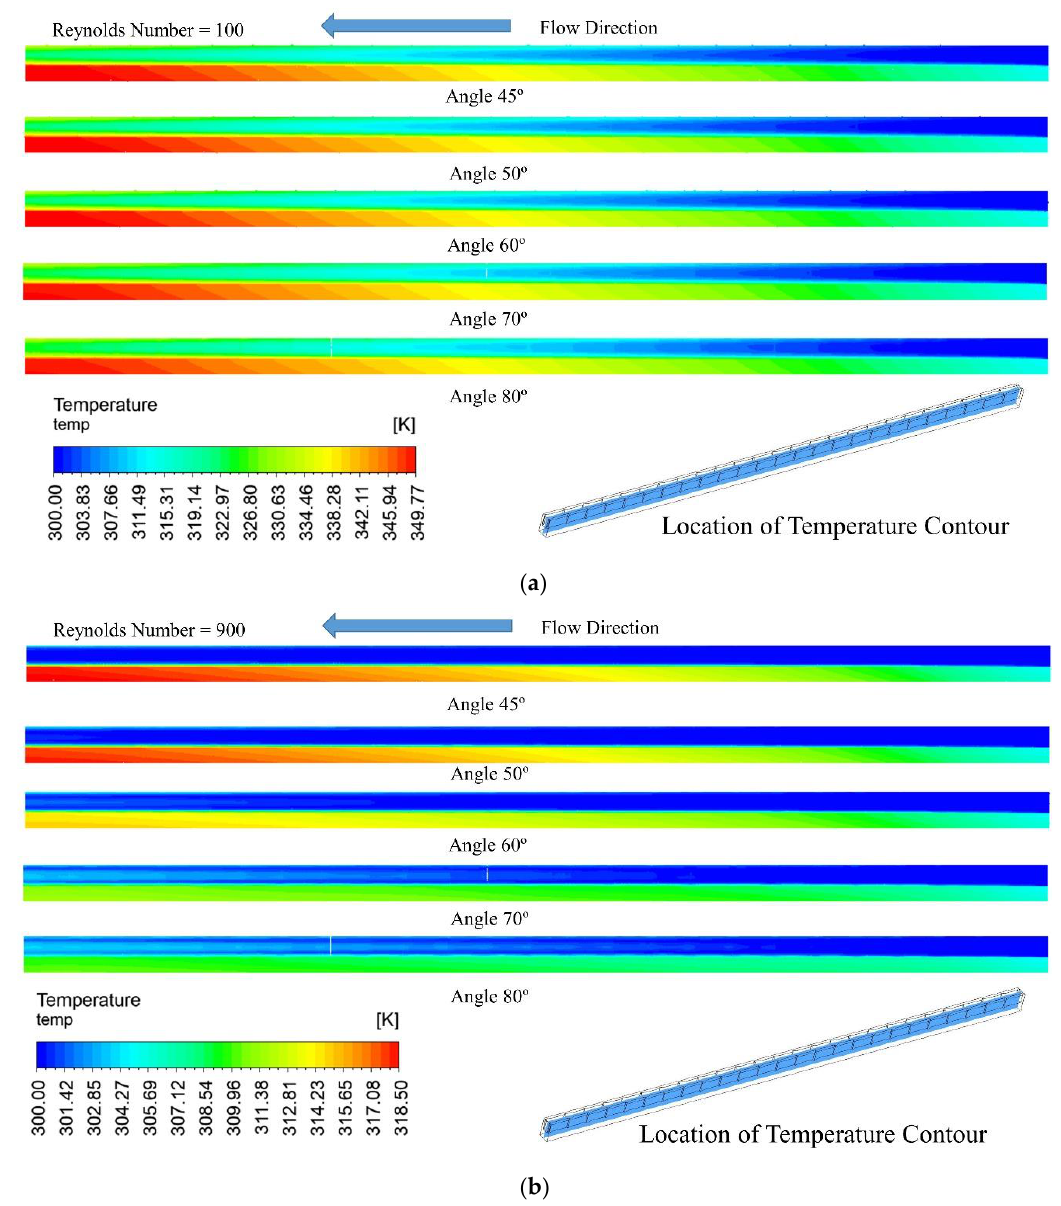
Figure 6. Pressure distribution in the fluid domain at ( a ) Re = 100 and ( b ) Re = 900 .